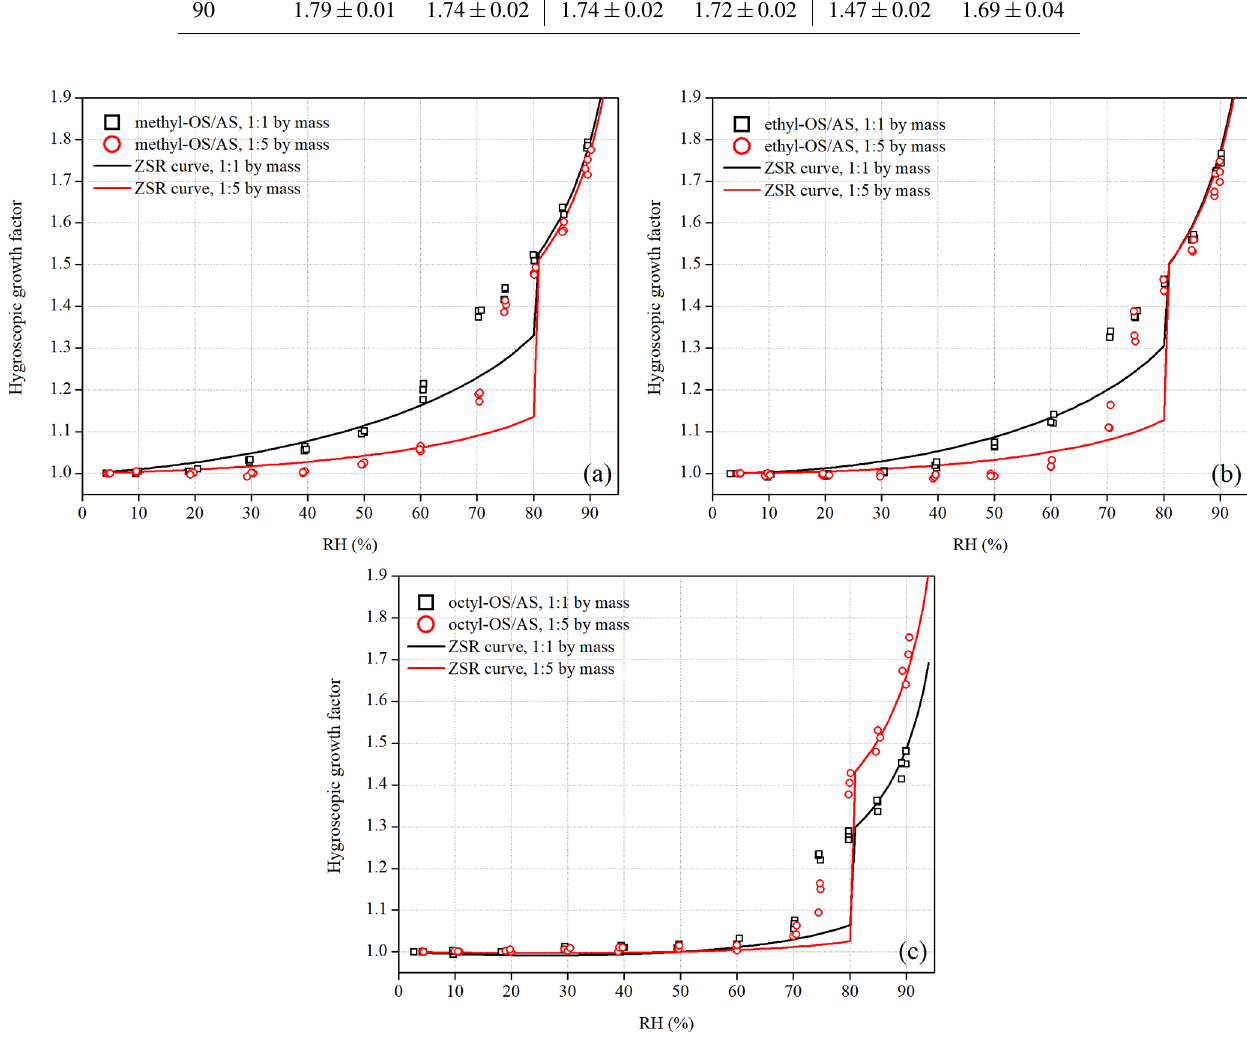
Figure 7. Hygroscopic growth factors of (a) methyl-OS / AS, (b) ethyl-OS / AS and (c) octyl-OS / AS aerosols as a function of RH. The mass ratios of methyl-, ethyl- and octyl-OS to AS were 1:1 and 1:5. Solid curves represent hygroscopic growth factors of mixed aerosols predicted using the ZSR